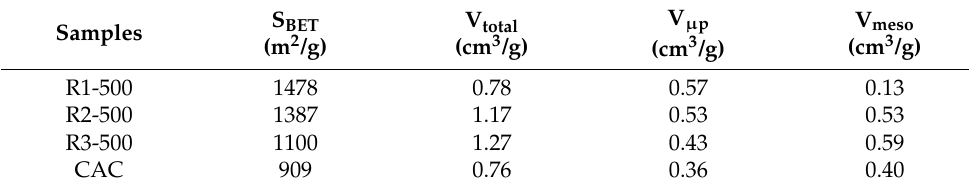
Table 4. Textural properties of the tested activated